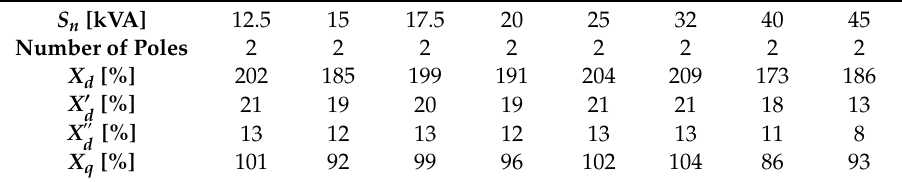
Table 2. Two-poles synchronous generators data with a rated voltage of 400 V from the Stamford company [18].